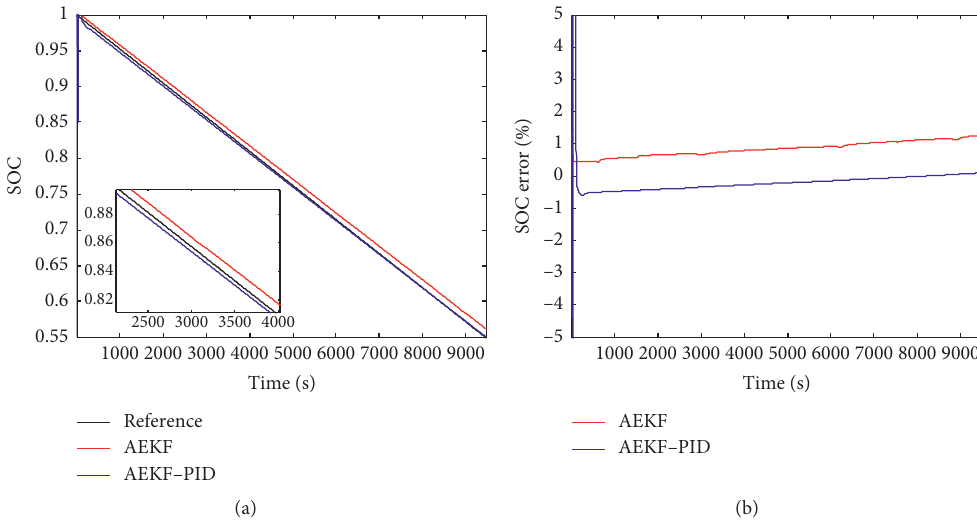
Figure 10: Comparison of SOC estimation under 10A discharge: (a) SOC estimation result; (b) SOC estimation error.